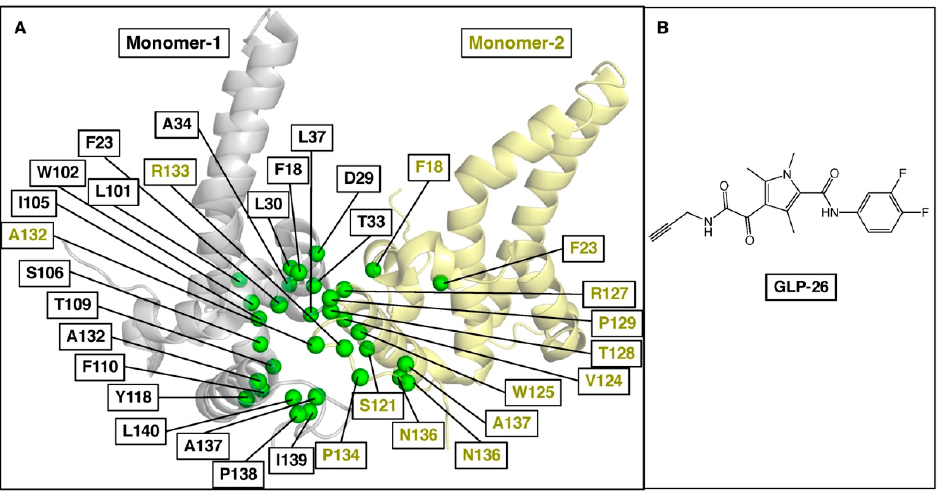
Figure 4. ( A ) Selected binding site residues between two monomer proteins of the HBV core to predict GLP-26 resistance mutations. The monomers are represented in gray and yellow, and their respective residues are in green. ( B ) Chemical structure of GLP-26.